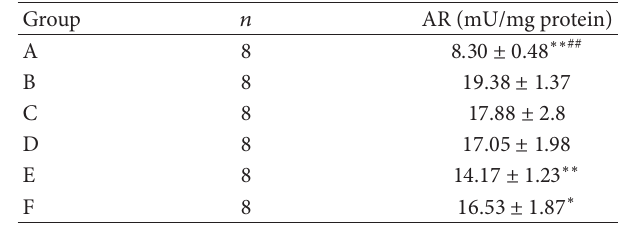
Table 3: The effect of rHV3 eye drops on the activity of AR in the lens on diabetic cataract in Sprague-Dawley rats ( 𝑥 ± 𝑠